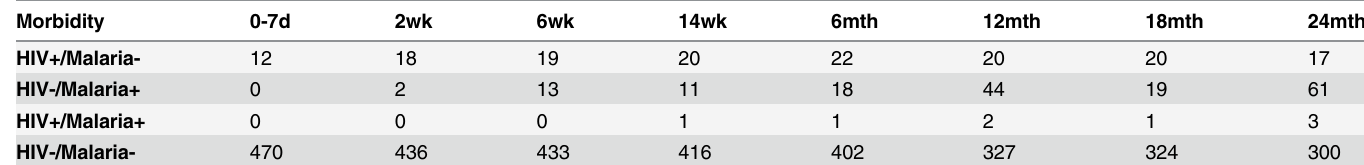
Table 2. HIV and Malaria co-morbidity among children, Kisumu Breastfeeding study, Kisumu, Kenya, July 2003- February, 2009. Morbidity